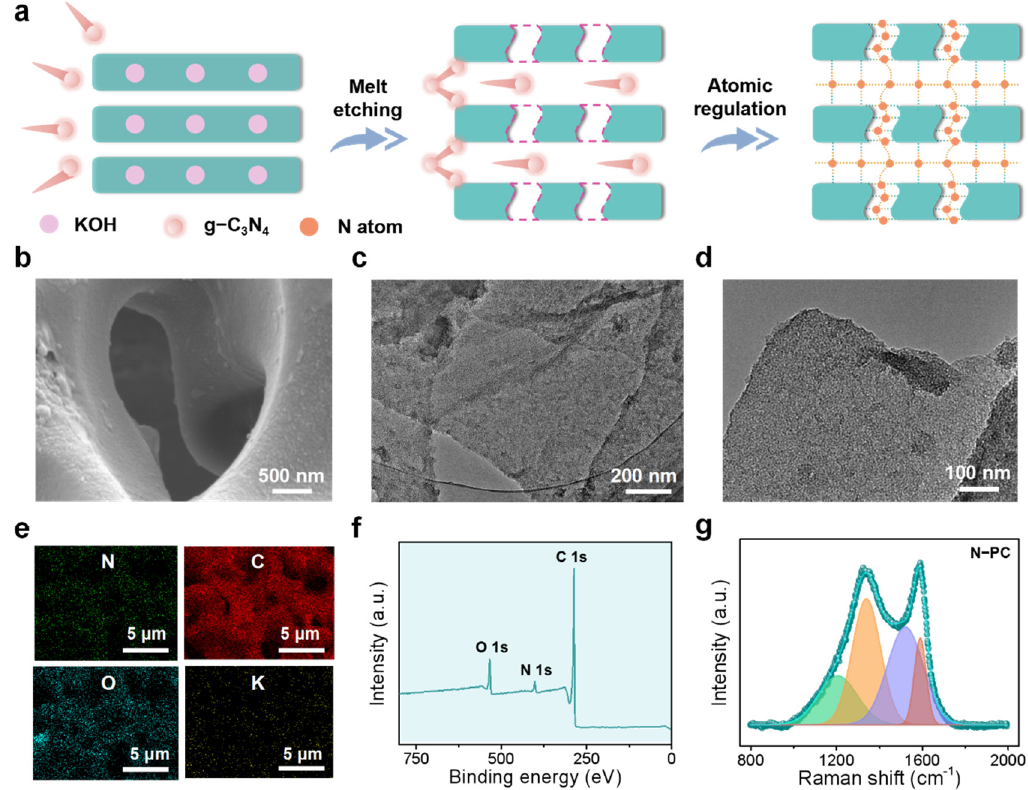
Figure 2. Structural design of N−doped porous carbon (N−PC). ( a ) Heteroatom-grafting strategy for the synthesis of N−PC with a continuously interconnected network. ( b ) Respective SEM image of N−PC with a three-dimensional skeleton structure and rough surface. ( c ) Typical TEM image of N−PC with a lamellar microstructure. ( d ) TEM image of N−PC with abundantly disordered struc- tures. ( e ) Element mapping images of N−PC for N, C, O, and K elements. ( f ) XPS survey of N−PC. ( g ) Raman spectrum of N−PC.